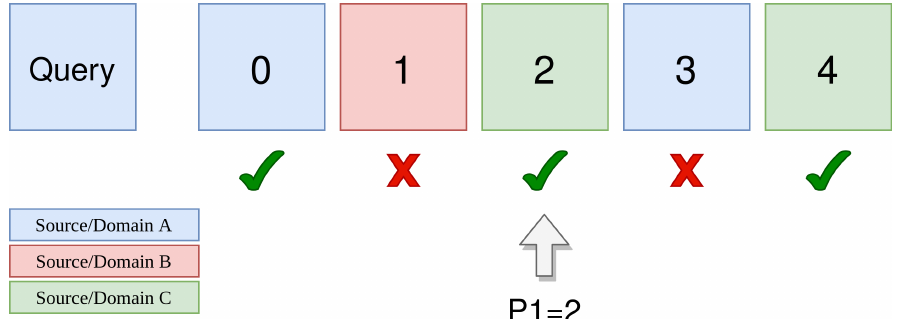
Figure 3. Calculation of P1, the position of the first positive image from a different domain (or collection), for a single query. Different colors indicate different domains, True/False symbols indicate if the corresponding image is positive or not for this query.